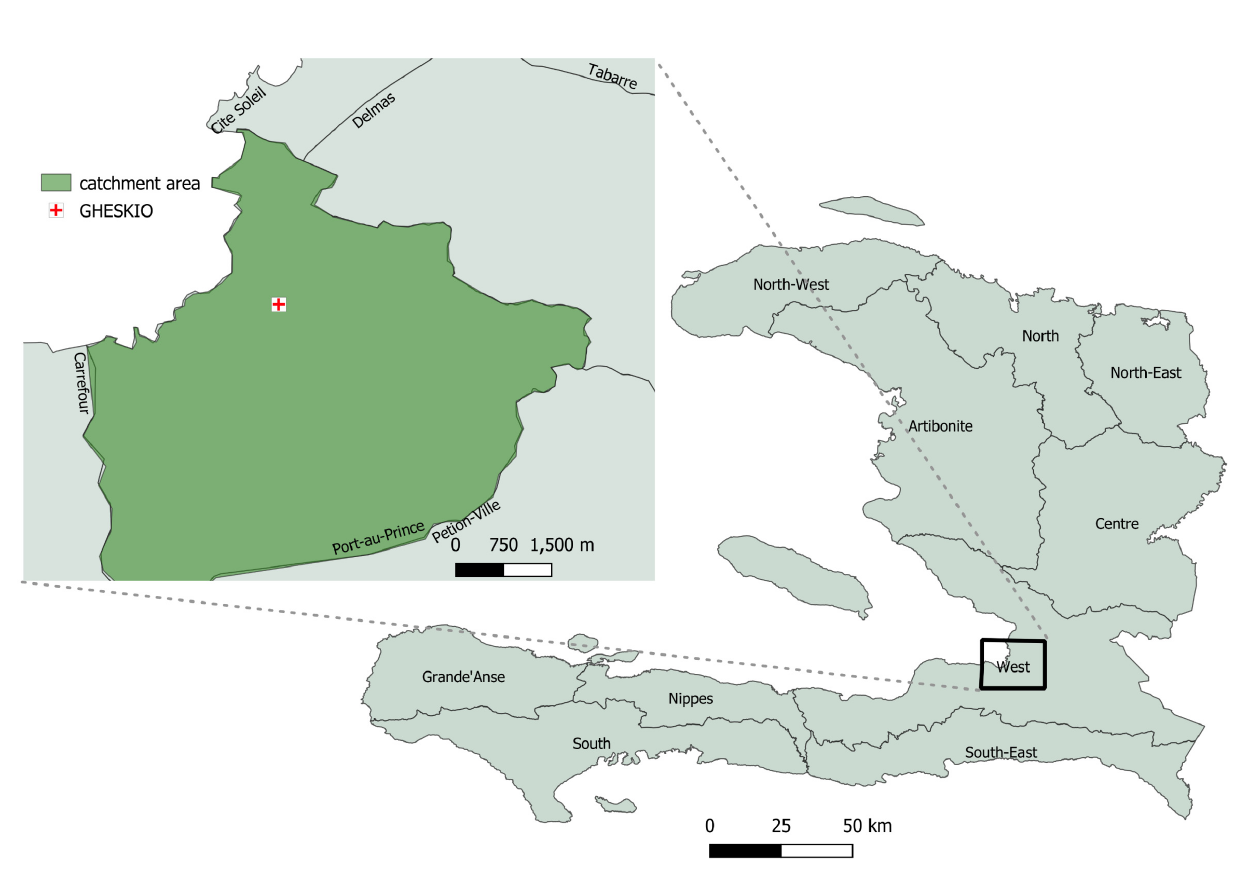
Fig 1. Map of census blocks sampled in Haiti CVD cohort. Map of sampled catchment area in Port au Prince. Base layer of map from Humanitarian Data Exchange, https://data.humdata.org/dataset/cod-ab-hti, CC BY IGO.